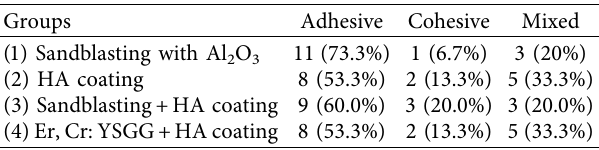
Table 2: Dispersion and type of failure mode among the 4 study